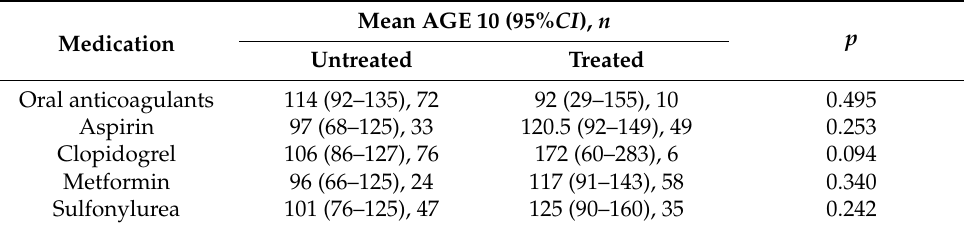
Table 4. AGE10 association with applied treatment.